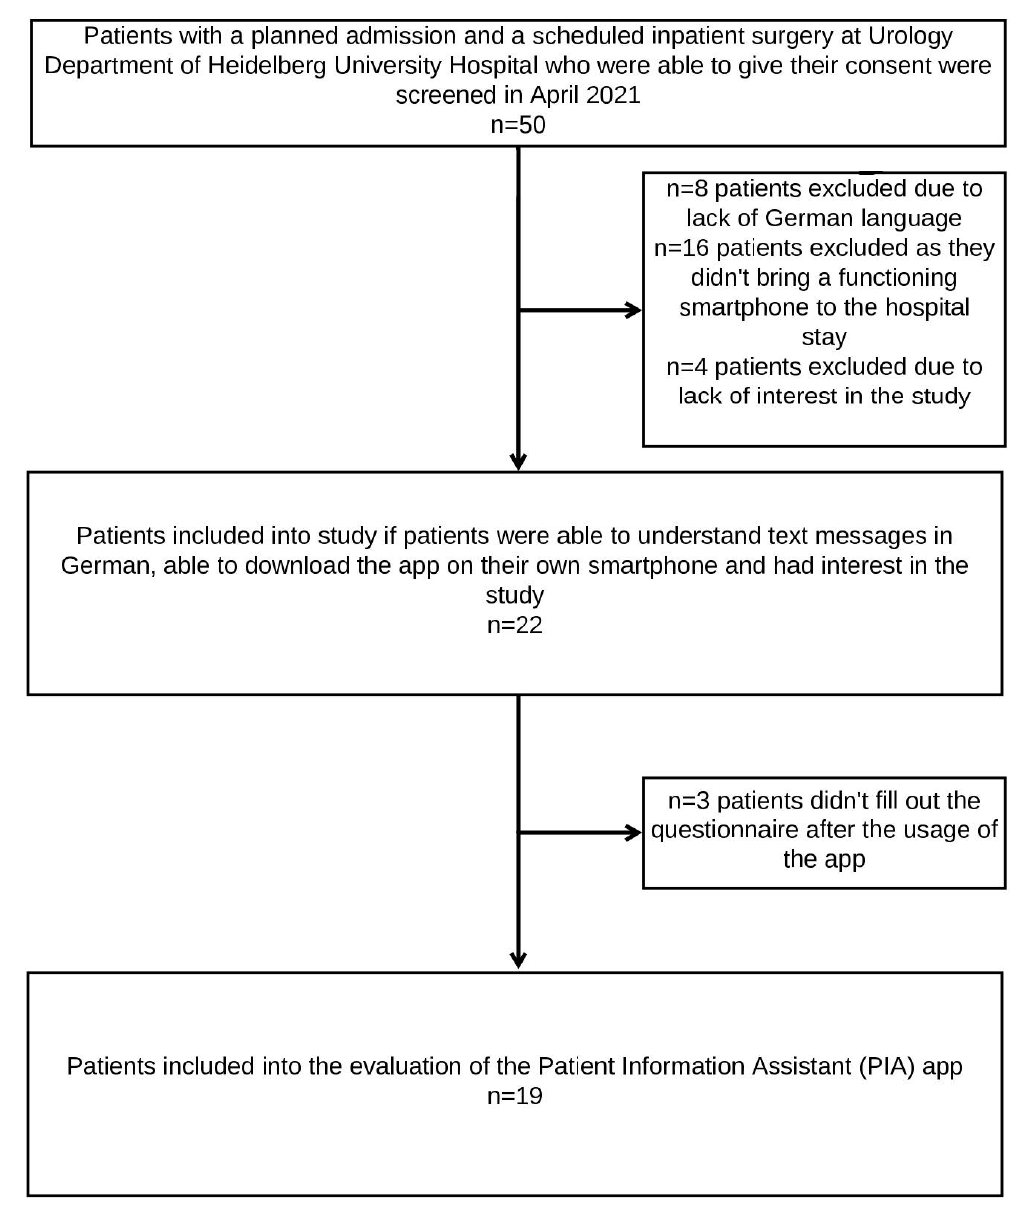
Figure 2. Flow chart for inclusion of study participants. Table 1. Study population.